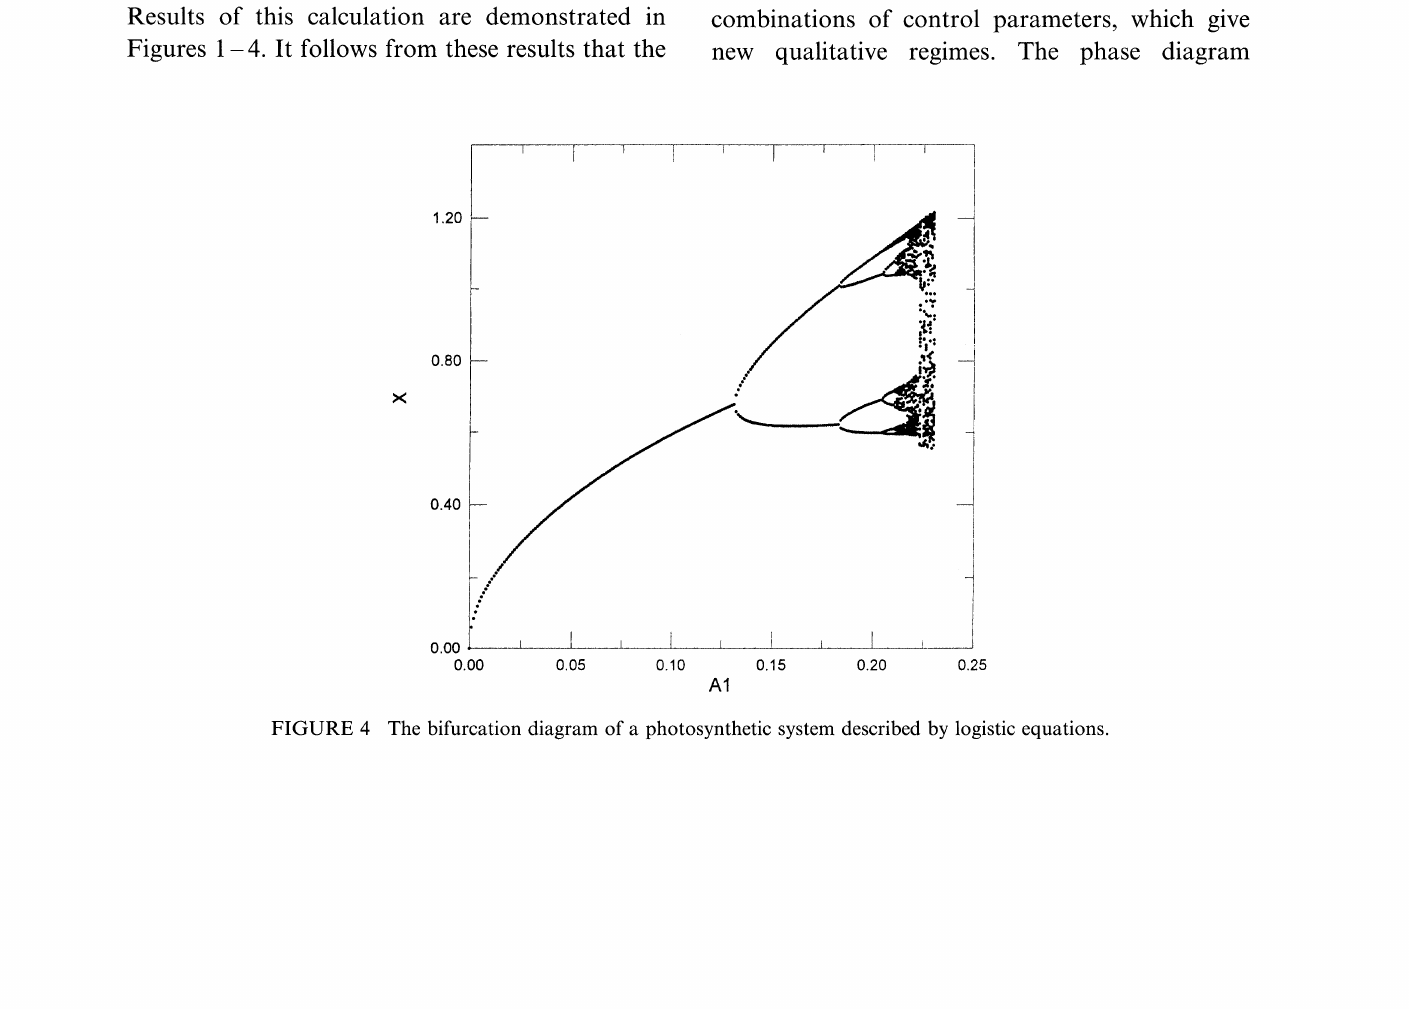
FIGURE 3 The fractal structure of the strange attractor belonging to the values given in Figure 5.